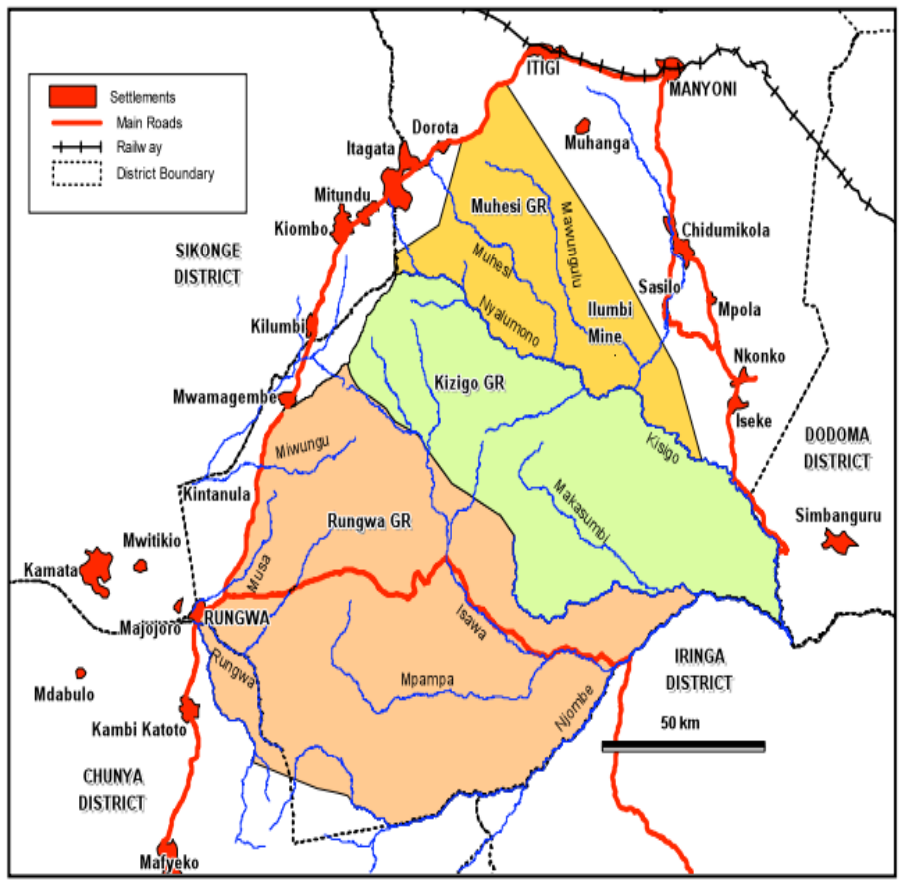
Fig. 1. Map of Ruaha-Rungwa Ecosystem showing the study area (Source: Ministry of Natural Resources and Tourism,